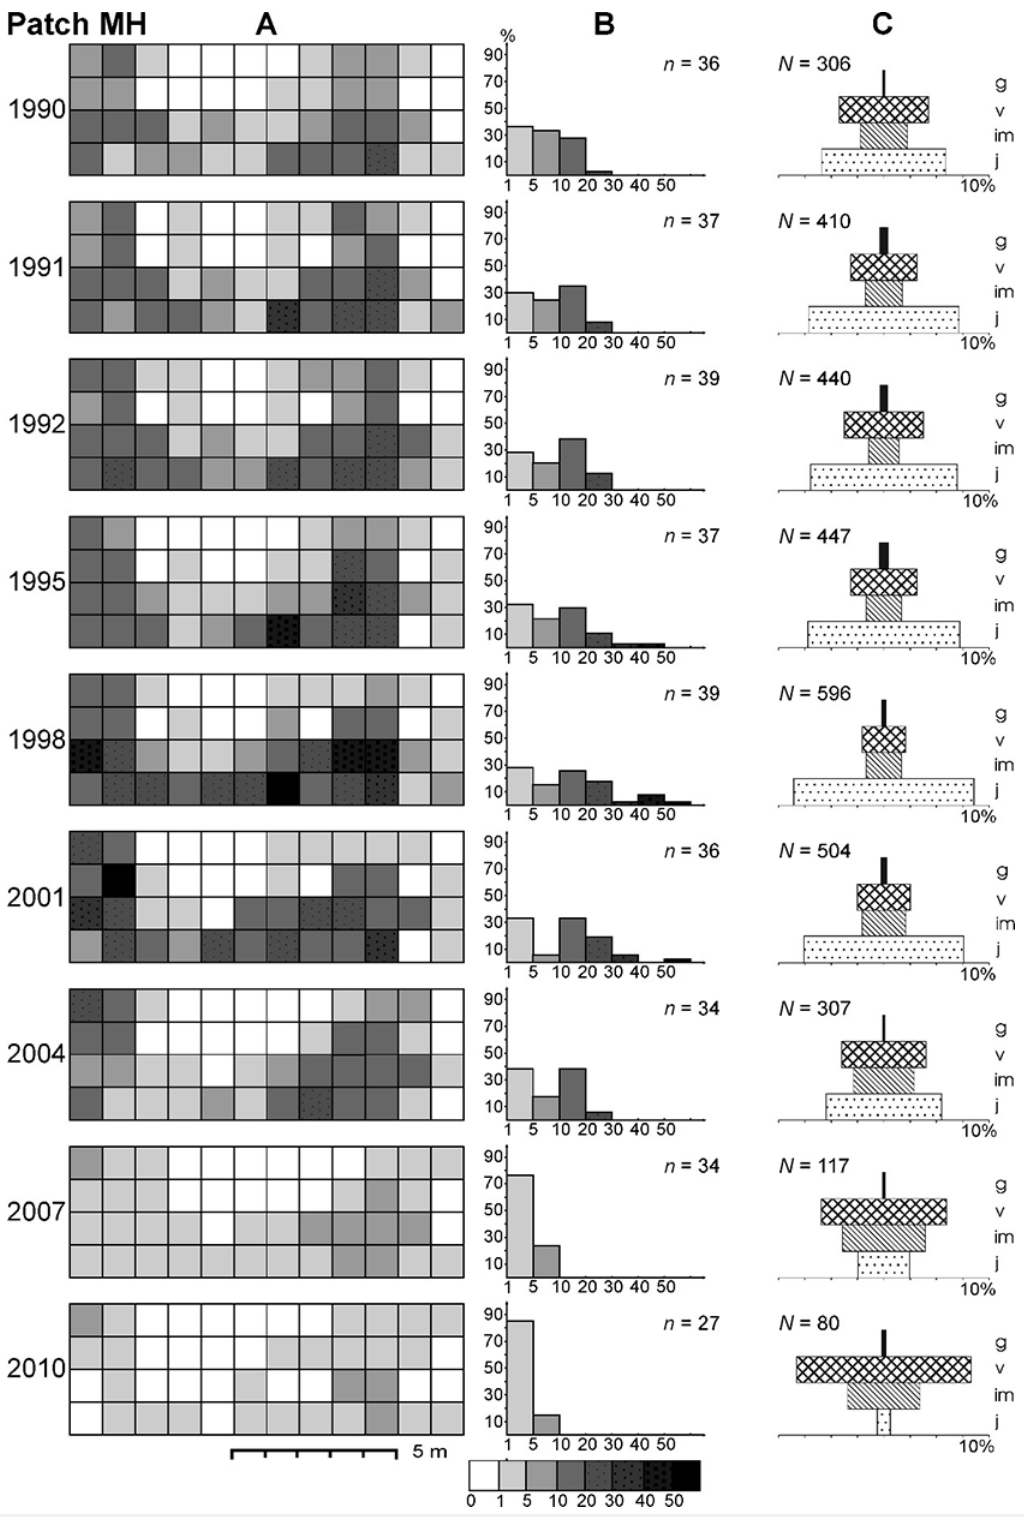
Figure 3 Dynamics of the Senecio umbrosus population within patch MH. For explanations see Figure 2.